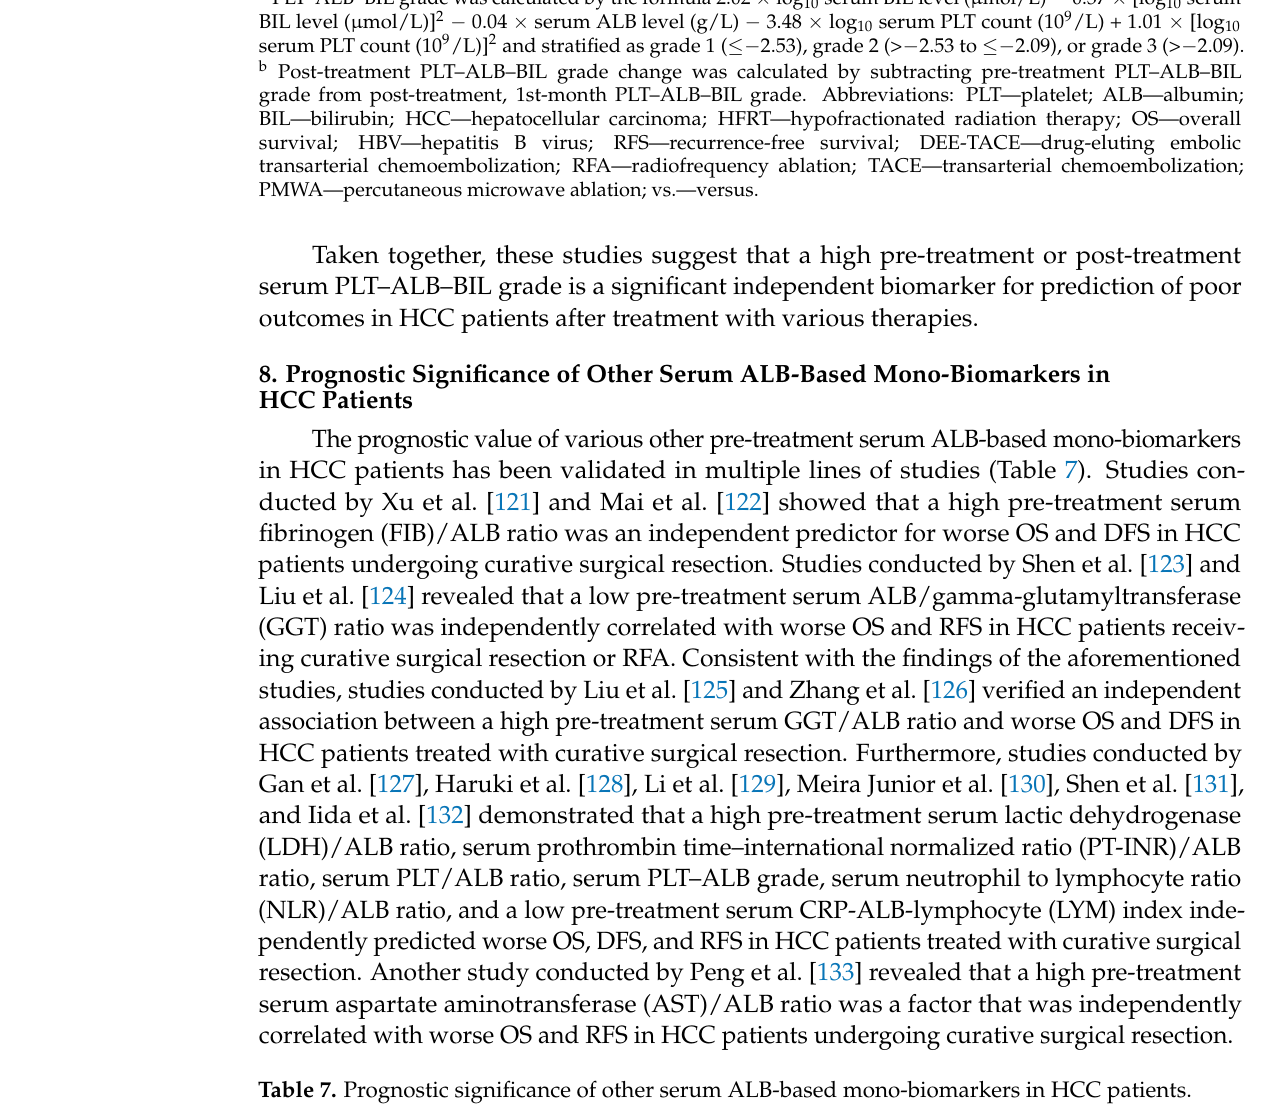
Table 7. Prognostic significance of other serum ALB-based mono-biomarkers in HCC